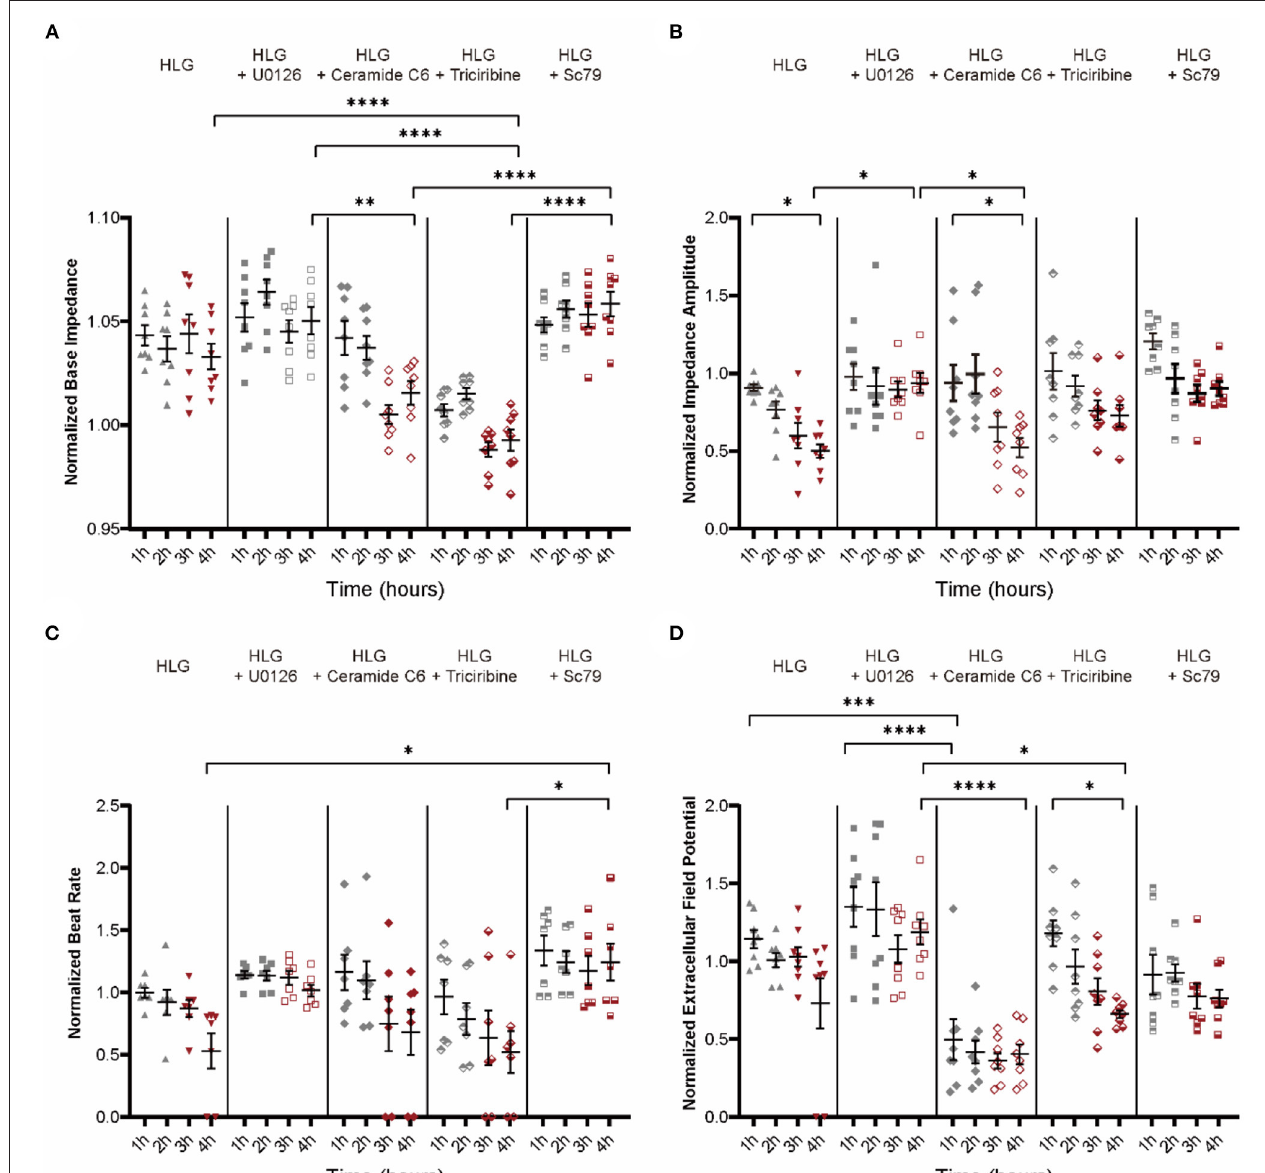
FIGURE 8 | Electrophysiology function of NMVMs after treatment with activators or inhibitors of MEK/ERK and PI3K/Akt pathways. (A–D) Analysis of base impedance [ (A) , n = 8 wells per condition], impedance amplitude [ (B) , n = 8 wells per condition], beat rate [ (C) , n = 7 wells per condition], and extracellular field potential changes [ (D) , n = 8 wells per condition] in drug-stimulated HLG NMVMs. Data are shown as mean ± SEM. One-way ANOVA test was used. * P < 0.05, ** P < 0.01, *** P < 0.001, **** P <